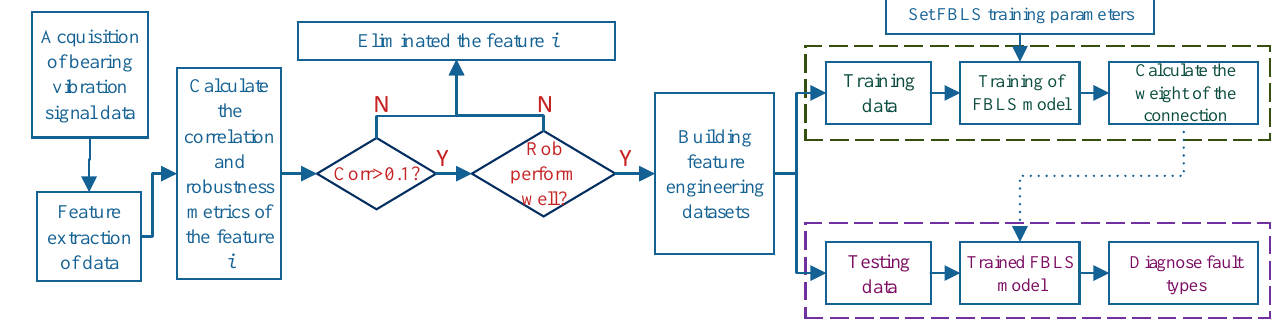
Figure 4. Fault diagnosis process based on feature engineering and FBLS method.